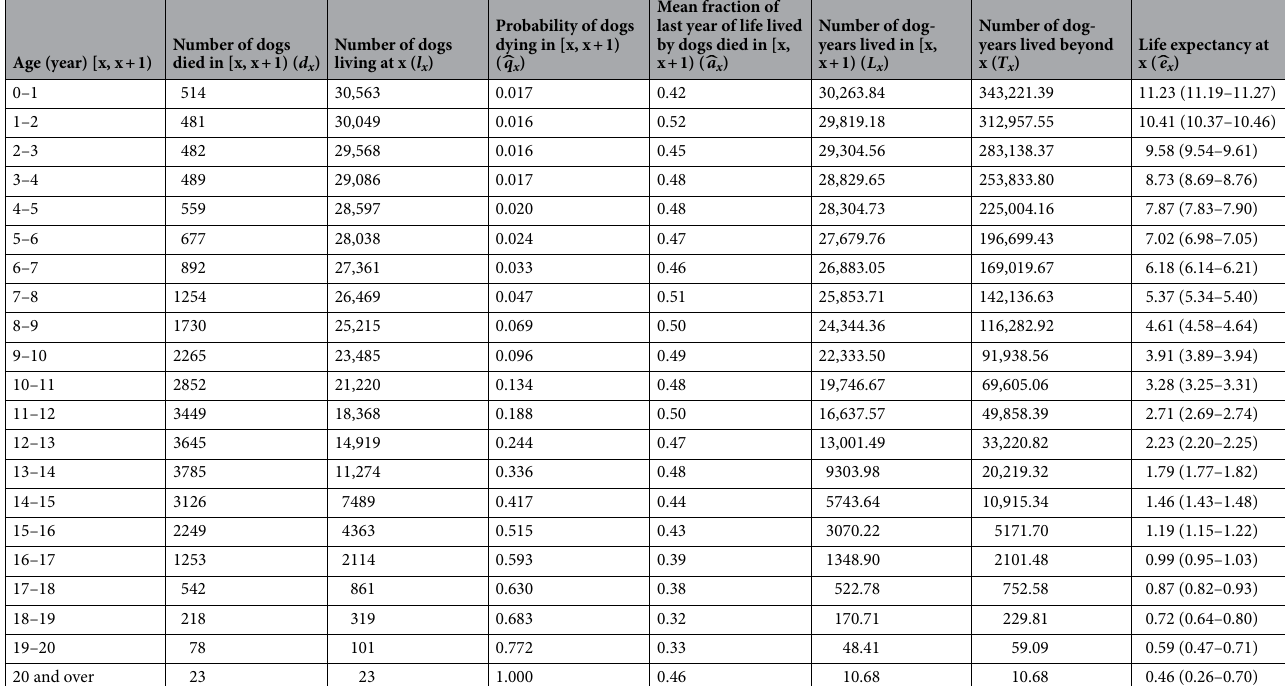
Table 2. Cohort life table of dogs under primary veterinary care in the UK. Each column is a feature of a typical life